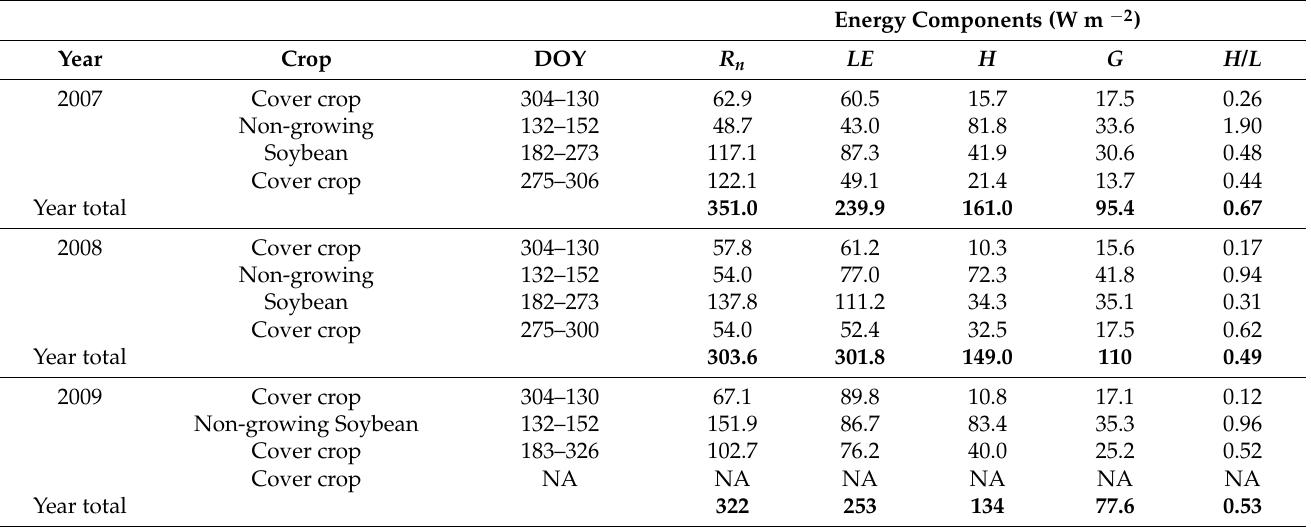
Table 1. Seasonal energy partitioning of the net radiation ( R n ) into latent heat ( LE ), sensible heat ( H ), and ground heat flux ( G ) and Bowen ratio ( H/LE ) during growing season of (winter wheat cover crop and soybean) and non-growing seasons. Numbers in bold are annual averages.